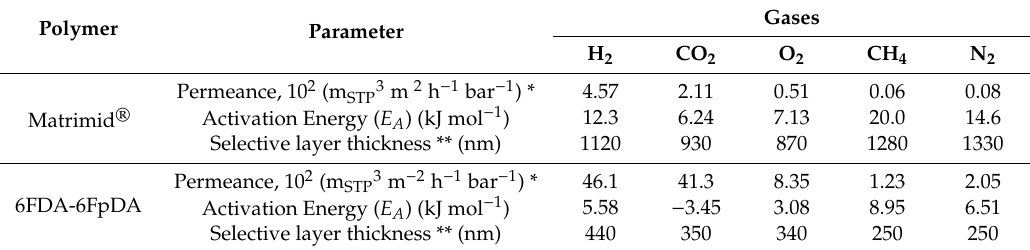
Table 2. Separation properties for the thin-film composite membranes at 30 ◦ C and the activation energy calculated in the temperature range from 30 to 70 ◦